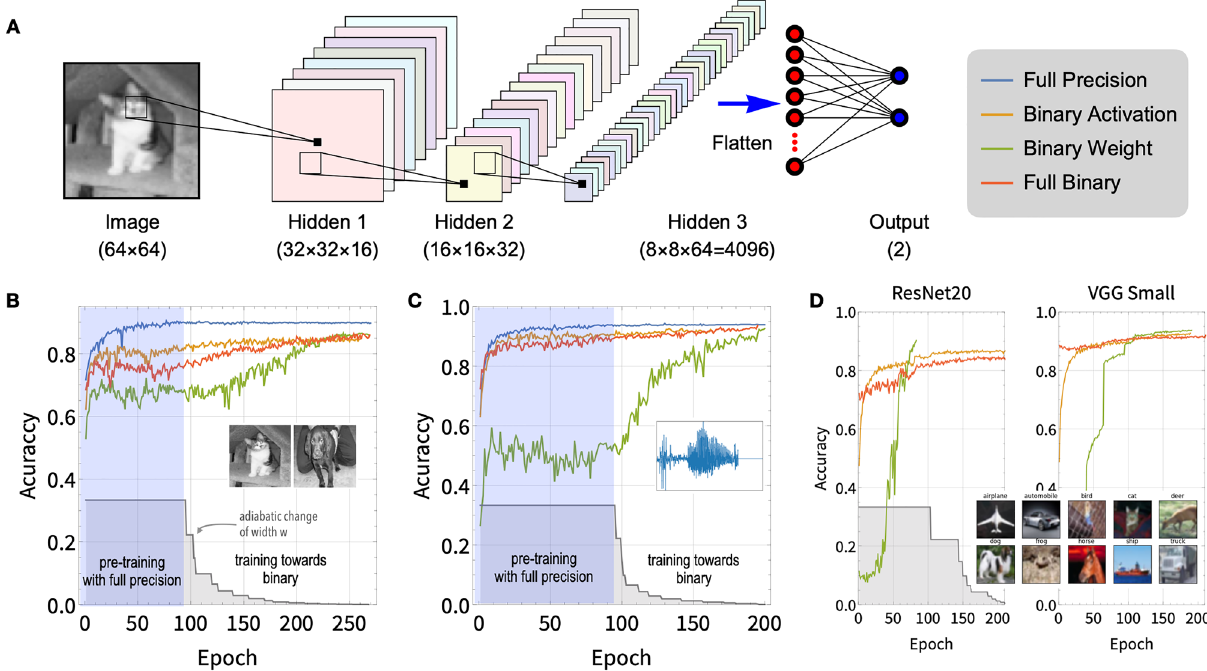
Figure 2. ( A ) The convolutional neural network with three hidden layers used for dog-cat recognition and the spoken number recognition. ( B ) The validating accuracies as function of number of epochs for the dog-cat task using networks trained with usual full precision (blue), binary activation (orange), binary weights (green), and full binary (red). All networks are trained from scratch. The gray stepwise curve shows the adiabatic change of width w towards zero as function of epochs. ( C ) Same as ( B ) for the spoken number task. ( D ) results for the CIFAR-10 recognition task based on the ResNet-20 and VGG-Small networks; binary-weight network starts from pre-trained (not shown) model, binary-activation nets are trained from scratch and full-binary nets start from the binary-activation network; for the latter two networks, batch normalization layers work in training mode for evaluation as drop-outs are used (inference mode is used for testing). Binary-weight ResNet-20 stops early because it already reached target accuracy. Full-precision accuracies for these two networks are 92.4% and 93.8% 12